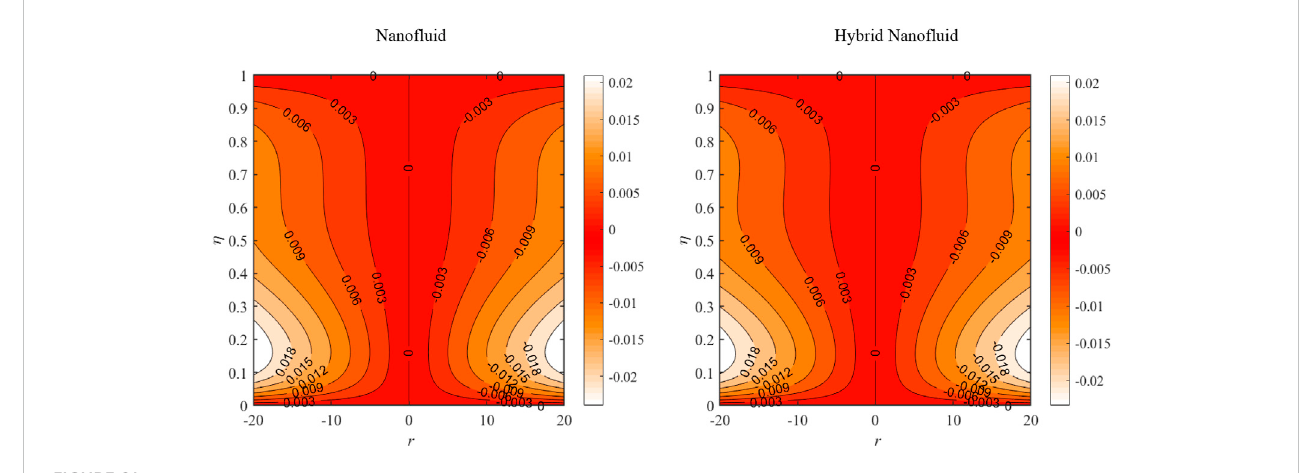
FIGURE 21 Streamlines for Nano fl uid and Hybrid nano fl uid.